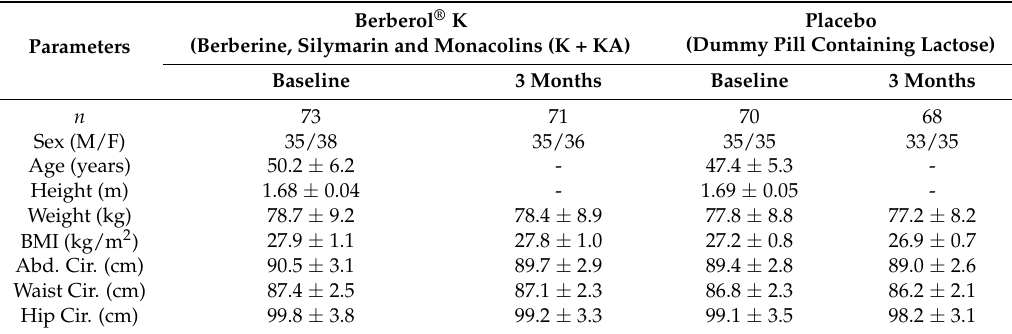
Table 1. Demographic and anthropometric characteristics with Berberol ® K and